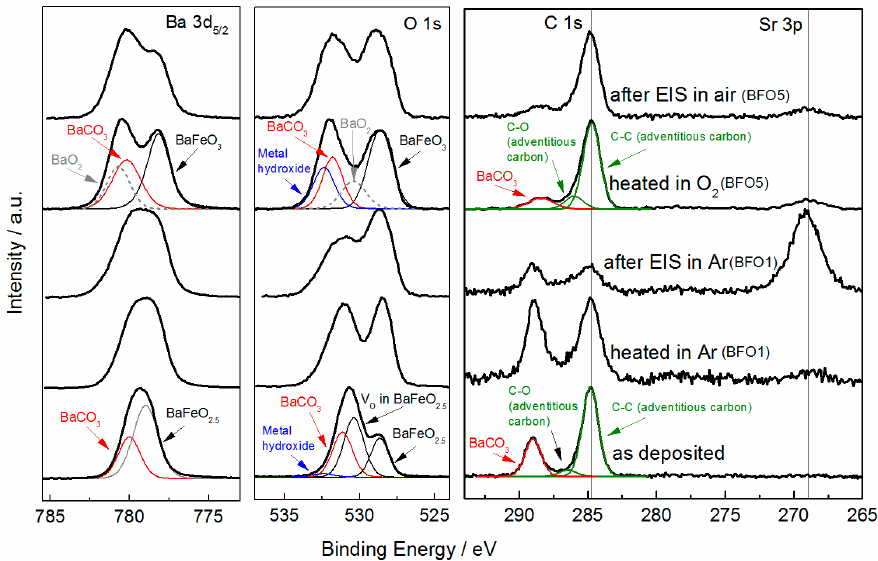
Figure 7. Background corrected XPS spectra of BFO thin films: Ba 3d 5/2 , O 1s and C 1s (Sr 3p ).